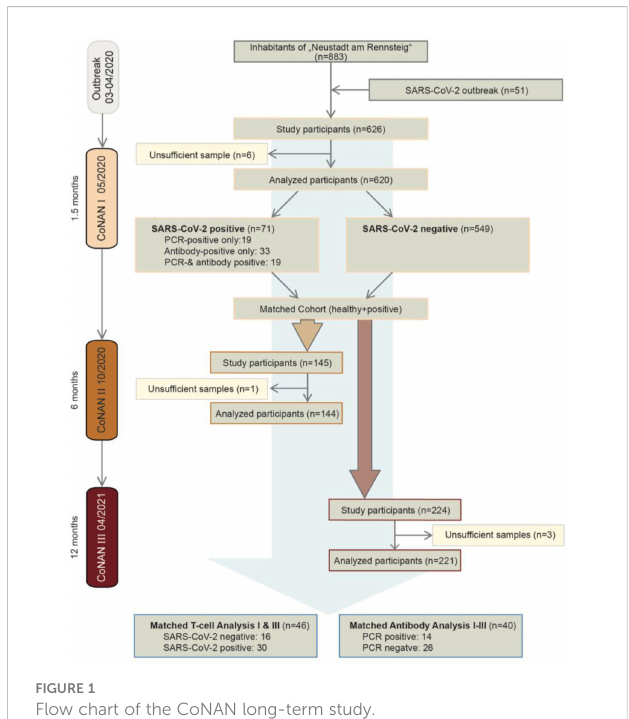
FIGURE 1 Flow chart of the CoNAN long-term